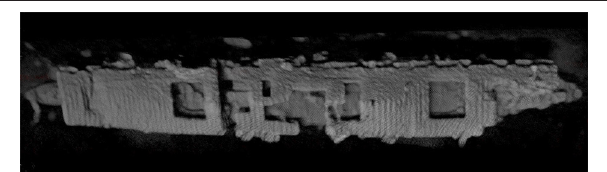
FIGURE 9 | Initial Sonar image of Independence